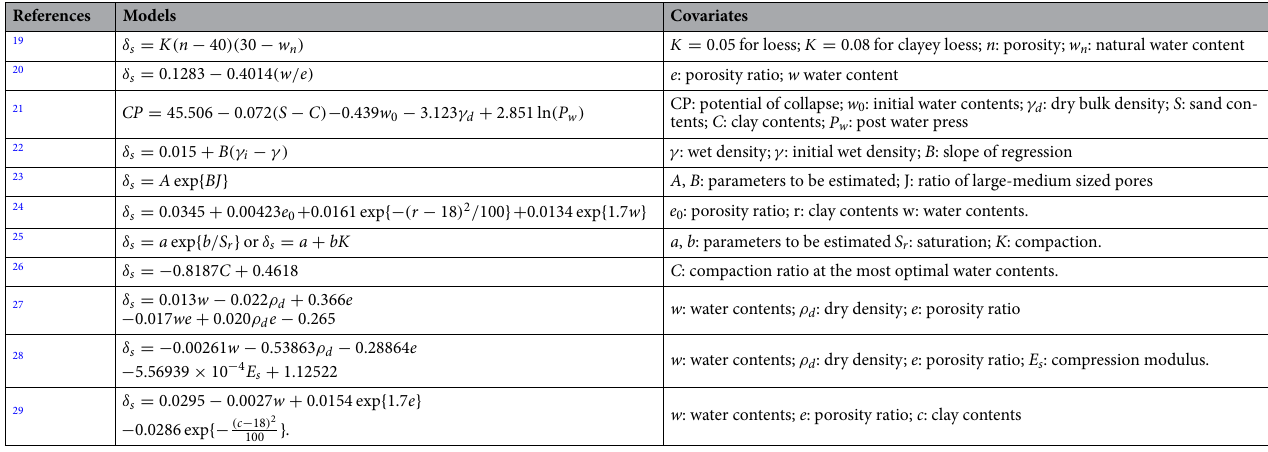
Table 1. Some models from previous studies.